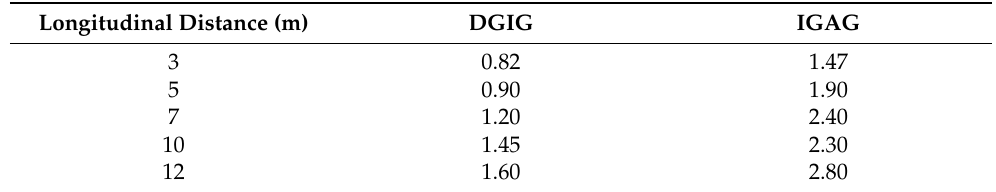
Table 3. Values of the lateral apoapsis corresponding to different glare perceptions at different longitudinal distances.